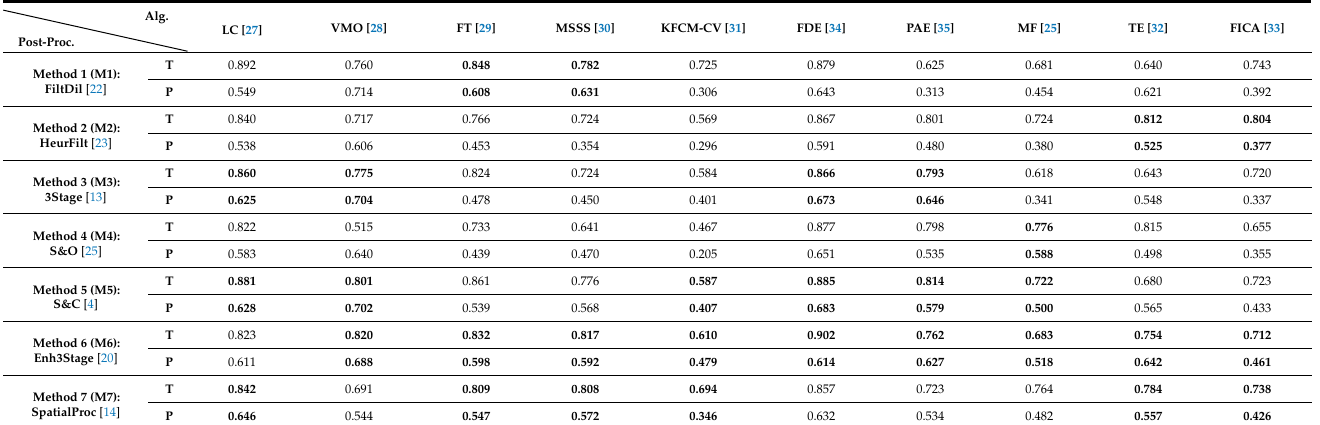
Table 3. Average F-score for seven post-processing methods combined with each of the ten algorithms for Tucson (T) and Phoenix (P) datasets.